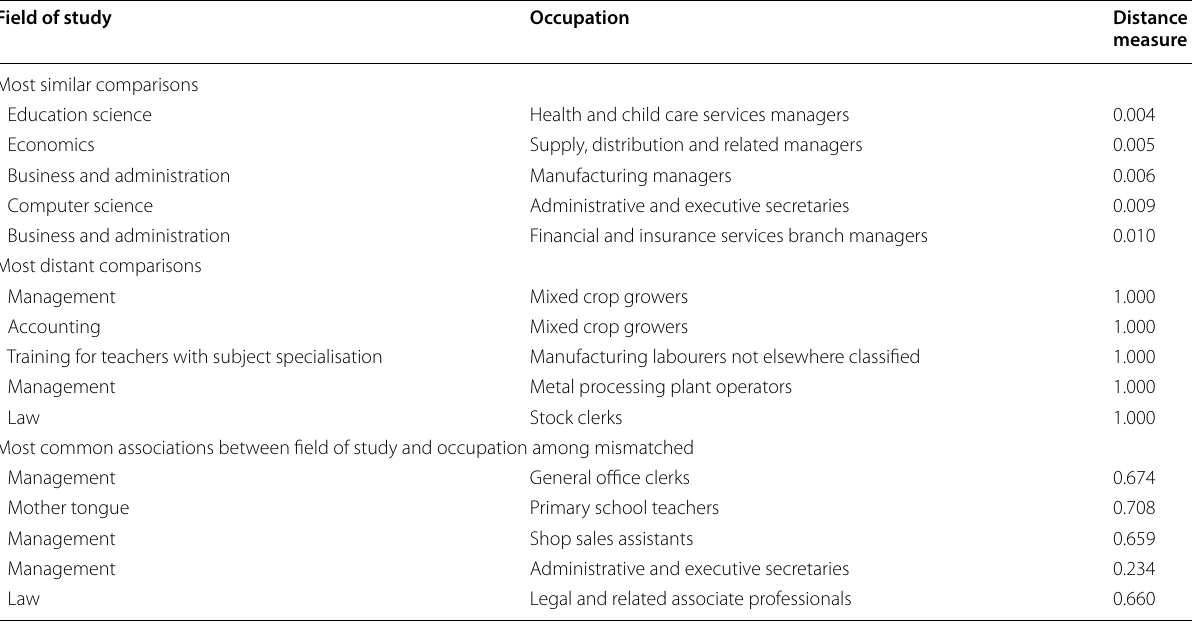
Table 7 Measuring distances between fields of study and occupations among mismatched workers. Source: the 2010 census